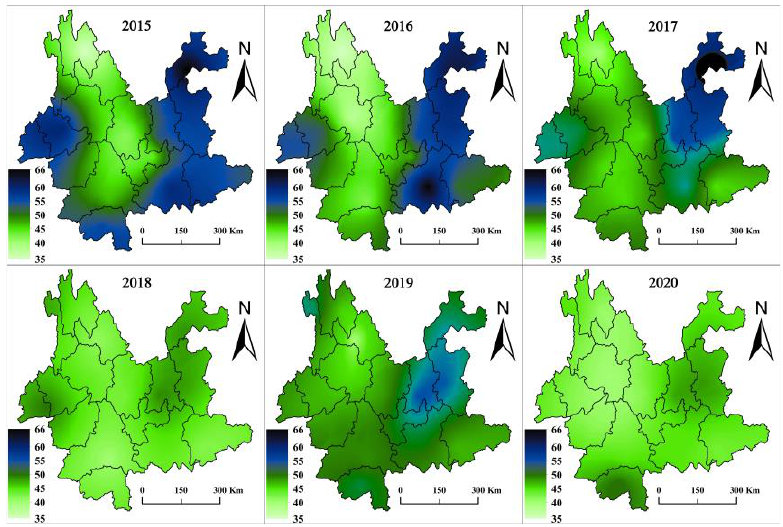
Figure 6. Distribution of annual average AQI values in Yunnan from 2015 to 2020.